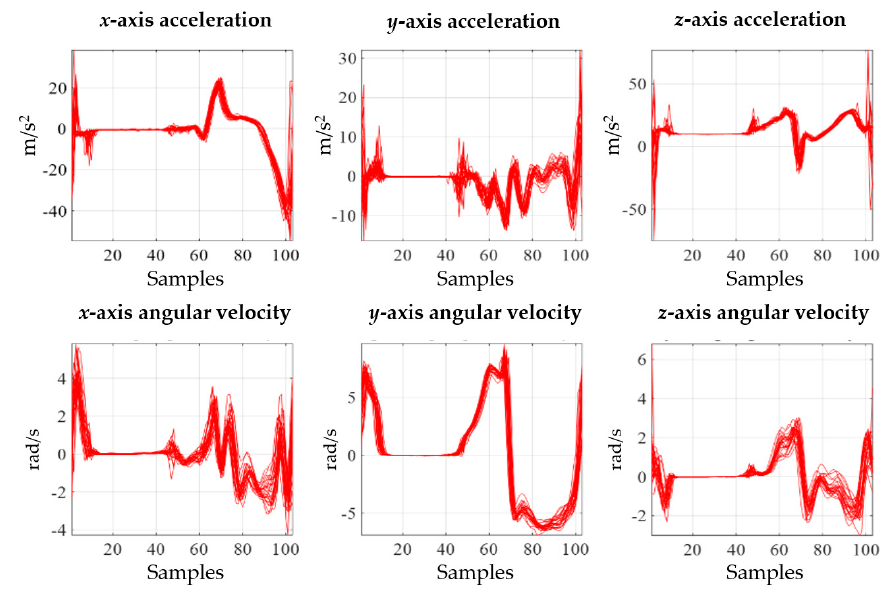
Figure 3. Acceleration and angular velocity signals.